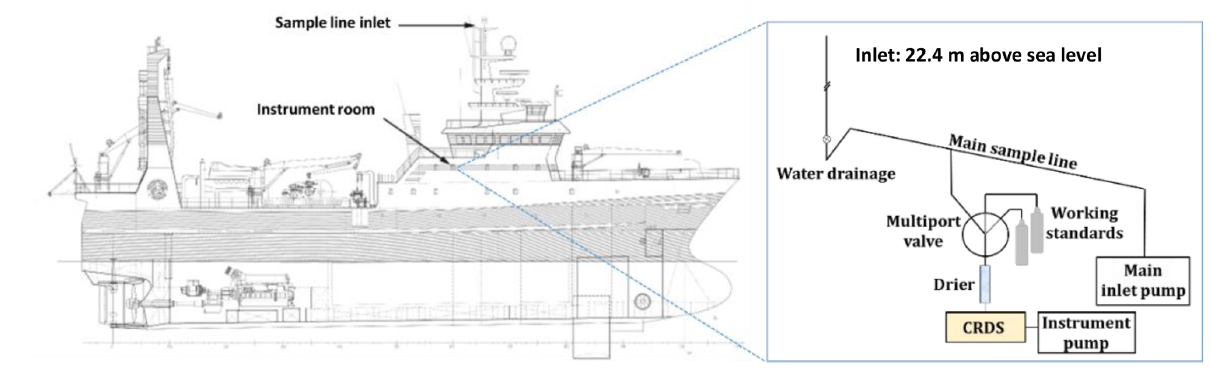
Figure 2. Schematic of the RV Helmer Hanssen showing the location of the sample inlet (to scale) and schematic of instrument room (not to